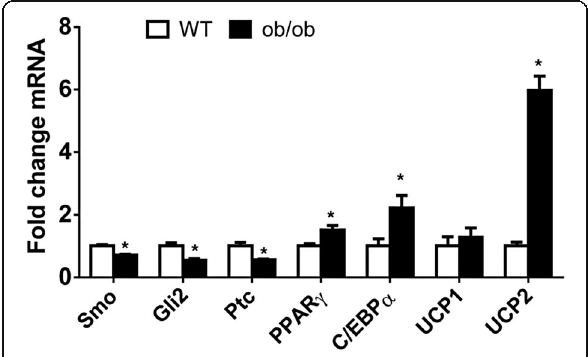
Fig. 7 Leptin-deficient Adipose-derived Mesenchymal Stem Cells are Smoothened Resistant. Adipose stromal vascular fractions isolated from WT and ob/ob mice were plated and cultured for 3 weeks to derive homogeneous mesenchymal stem cell populations for RNA isolation. Hh-related genes and markers of adipocyte differentiation were evaluated by qRT-PCR. Results were normalized to WT cells. * p < 0.05 vs